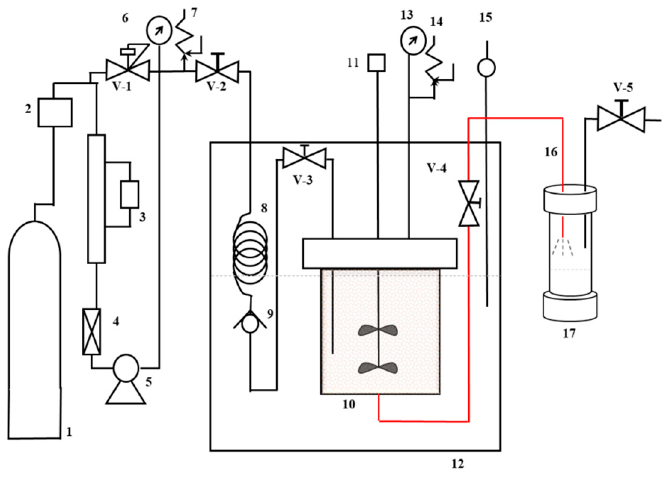
Figure 2. Schematic diagram of apparatus used in PGSS process. 1: gas cylinder, 2: dryer, 3: cool- ing unit, 4: filter, 5: pump, 6: pressure gauge, 7: safety valve, 8: preheater, 9: check valve, 10: high- pressure cell, 11: agitator, 12: water bath, 13: pressure gauge, 14: safety valve, 15: thermometer, 16: depressurization tunnel, and 17: atmospheric collector vessel with water. V-1 indicates a back- pressure regulator, and V-2 to 5: stop valves.